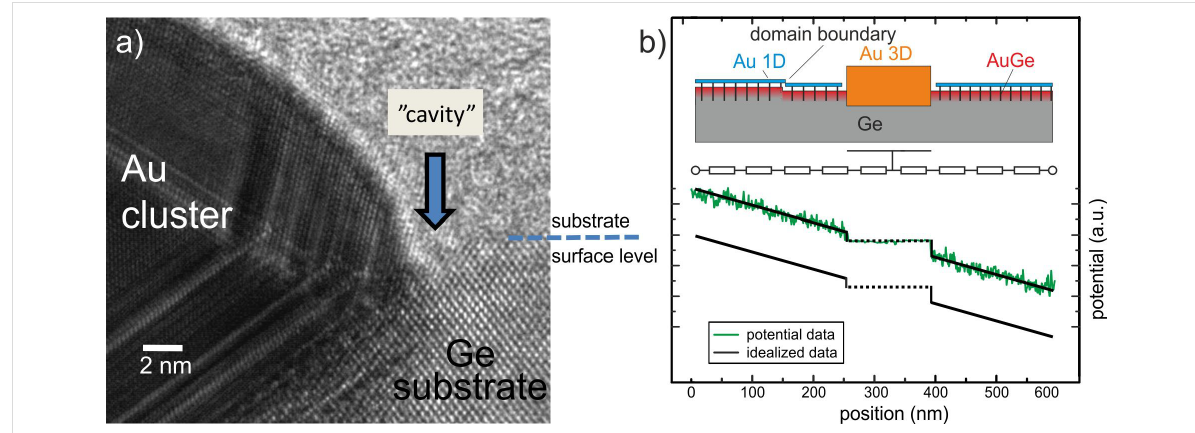
Figure 5: a) An atomically resolved HRTEM image of the interface between the Au cluster and the surrounding substrate surface. The substrate surface level is indicated with the dashed line. The arrow points to the discontinuity region (“cavity”) between the crystalline substrate surface region and the Au cluster. b) Scheme of the Au/Ge(001) sample structure. The Au cluster is electronically decoupled from the Au atomic wires but is coupled to a buried Au-enriched layer. The Au atomic wires are also coupled to this buried subsurface layer. The simplified wiring diagram is shown in the middle and a potential profile from original data and its simplified form is also shown.